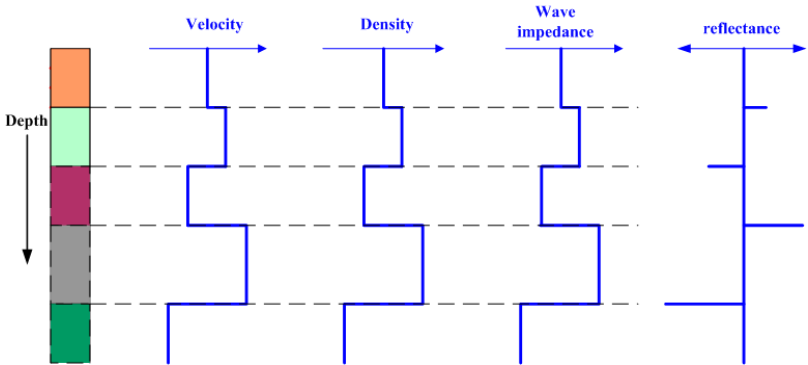
Figure 1. Schematic diagram of the relationship between velocity, density, reflection coefficient and wave impedance.